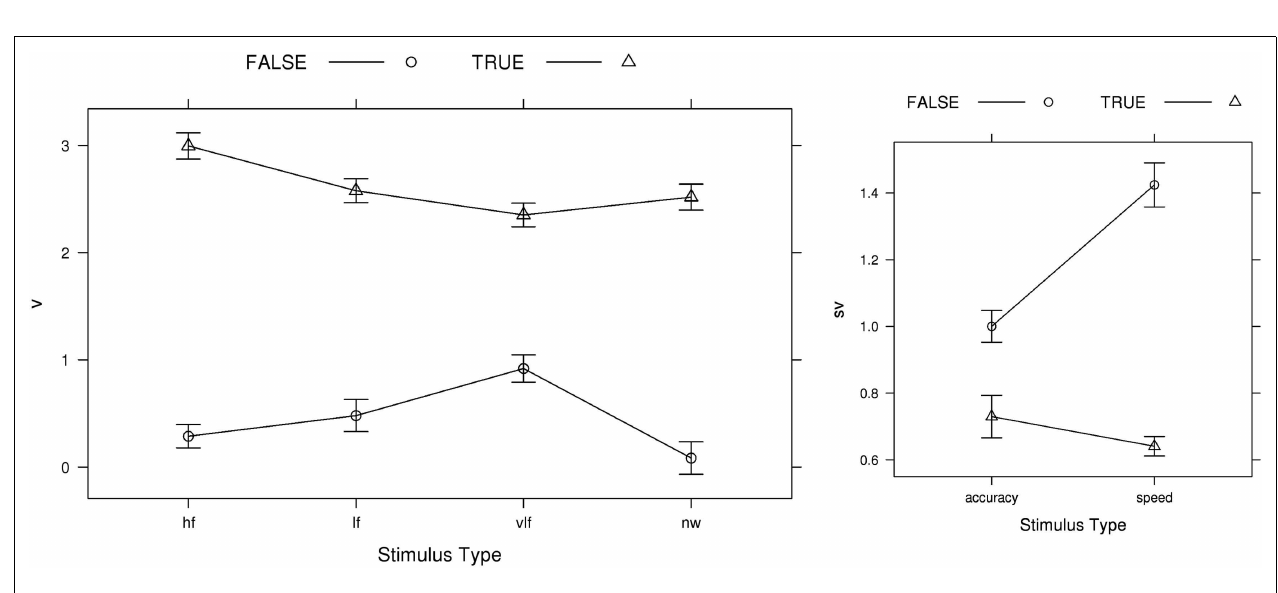
FIGURE 7 |AIC-best LBA ( B ∼ lR ∗ E & A ∼ E & v ∼ W ∗ C & sv ∼ E ∗ C & t 0 ∼ E ) v (mean rate) and sv (rate standard deviation) parameter estimates averaged over participants, with bias-corrected within-subject